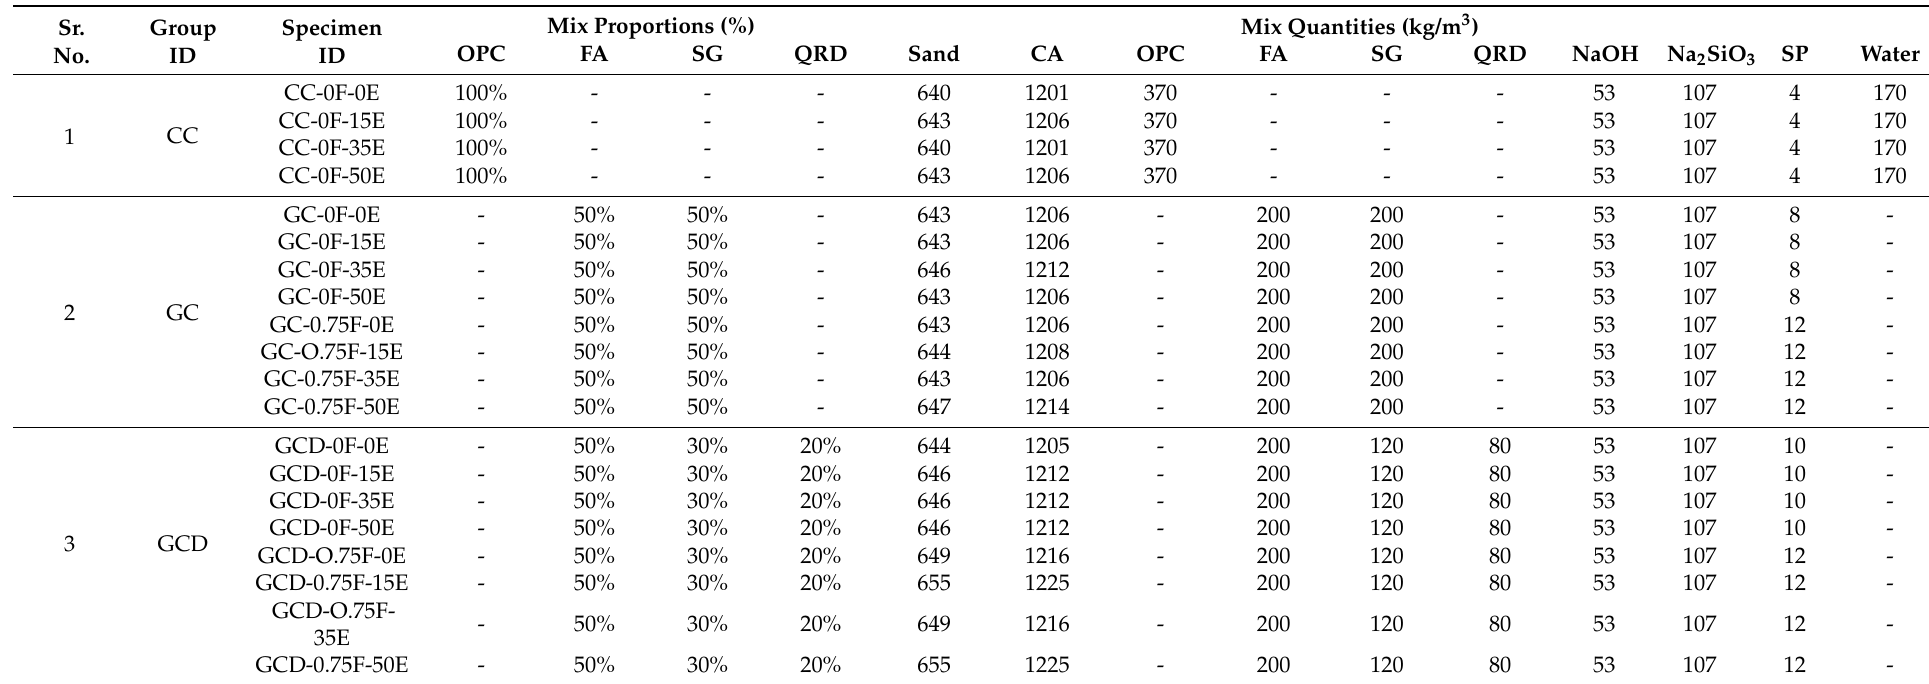
Table 1. The detail of proportions and material quantities of mixes used in the study.